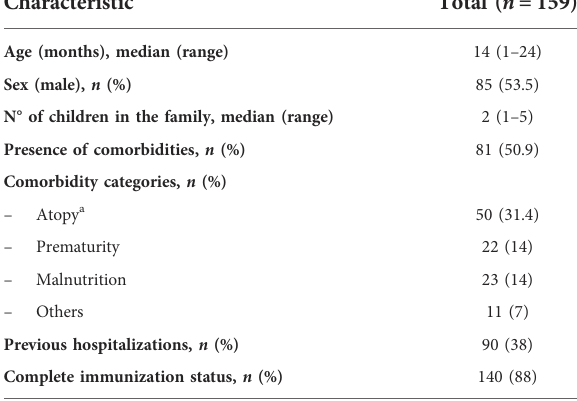
TABLE 2 Clinical features at initial presentation in 159 pediatric patients with